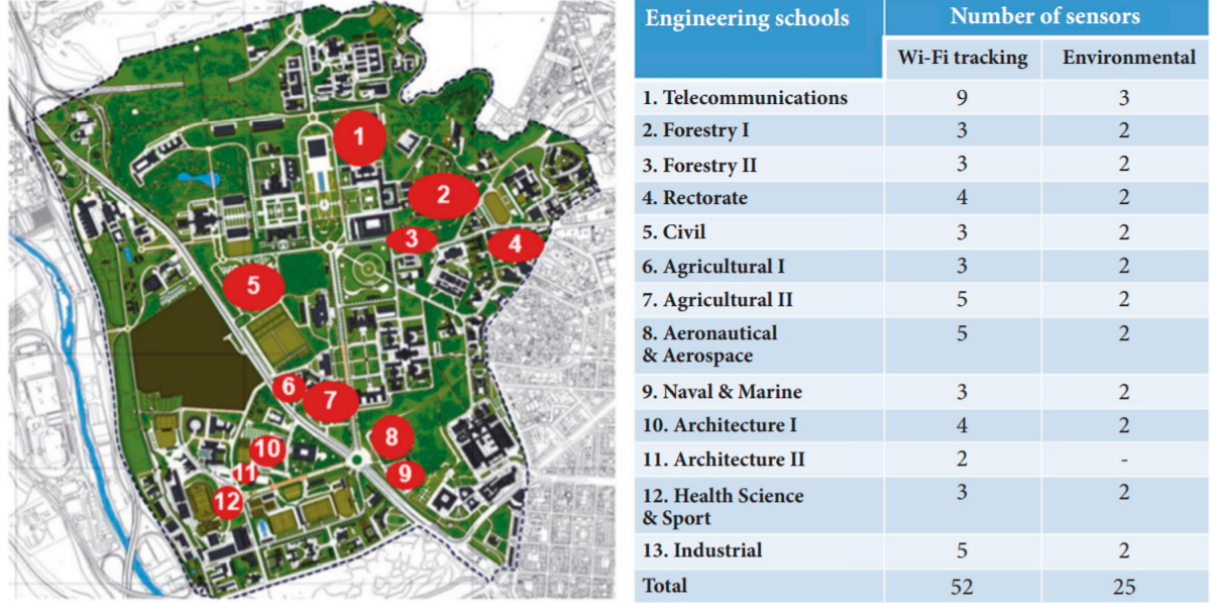
Figure 6. Summary of the sensors currently deployed in Smart CEI Moncloa [15] .